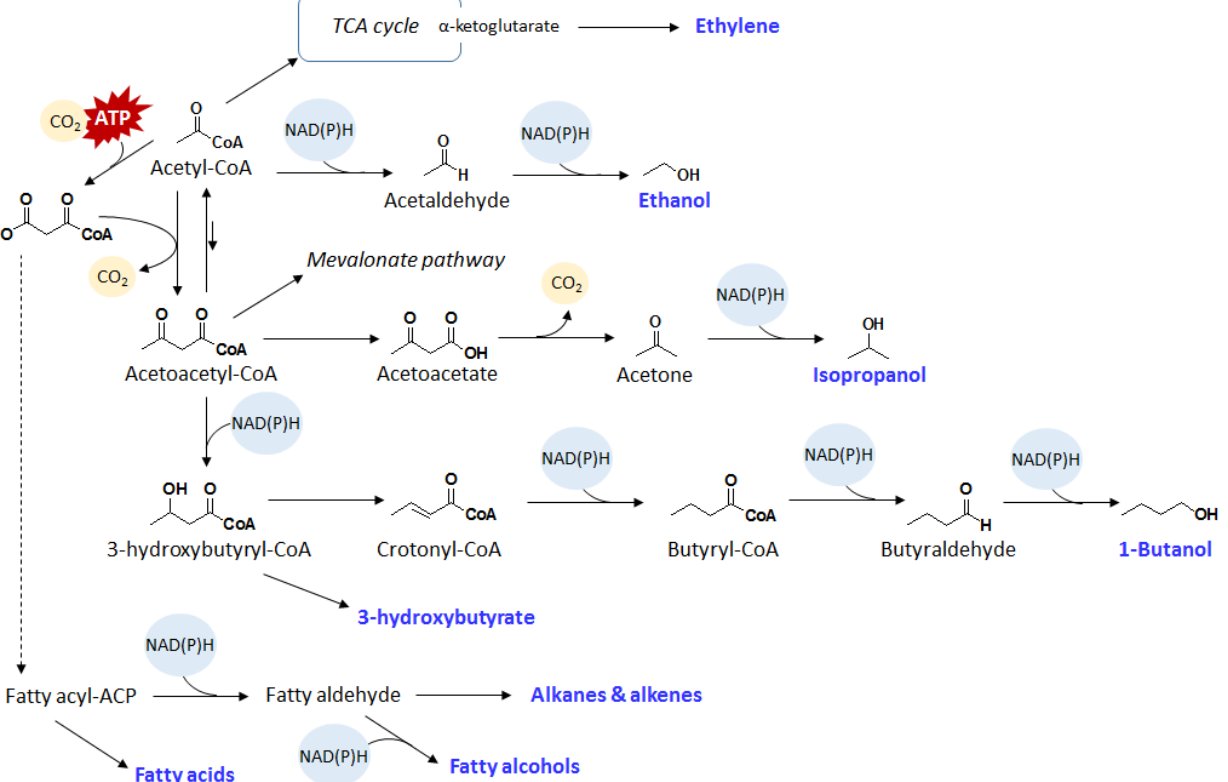
Figure 3. Schematics of acetyl-CoA derived bioproducts. Dashed lines represent multiple enzymatic